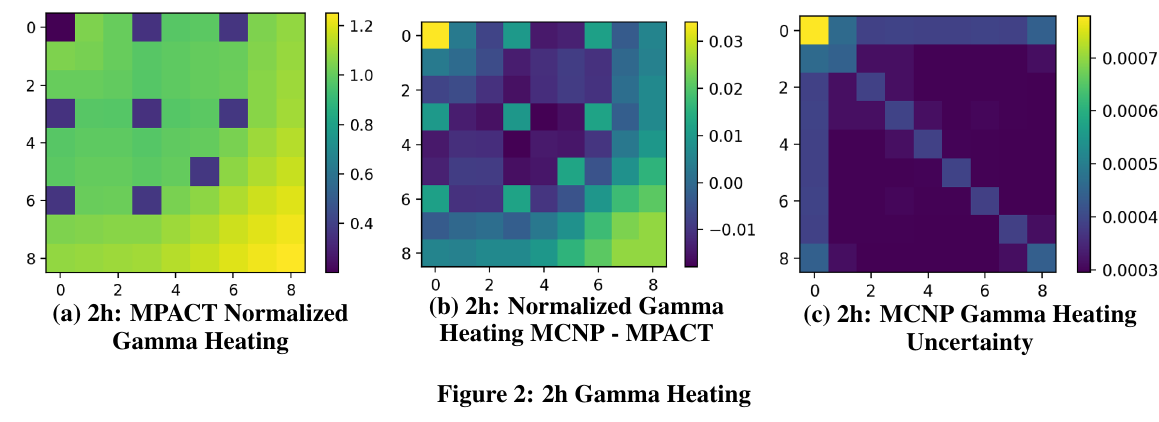
Figure 2: 2h Gamma Heating